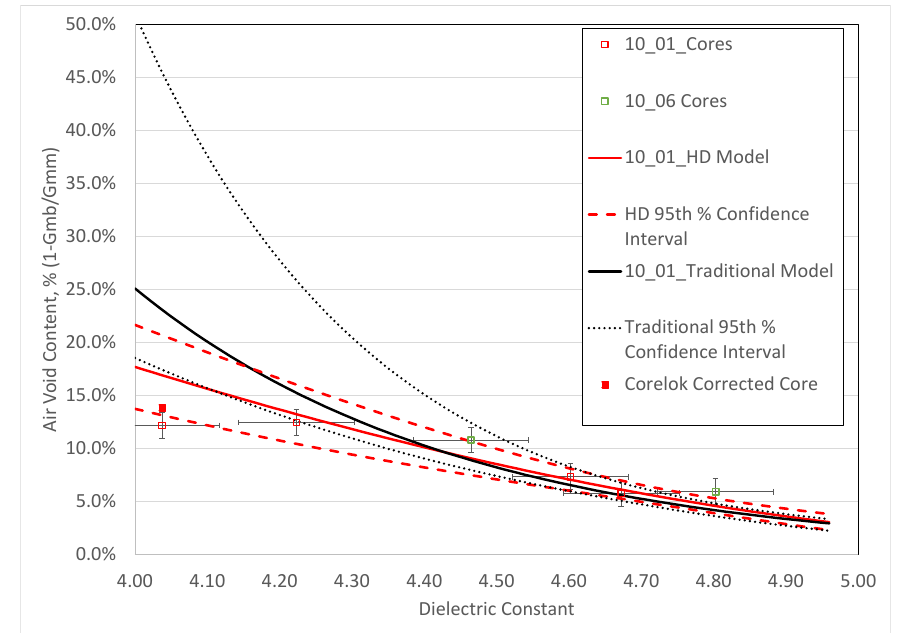
Figure 20. Prediction stability of Hoegh – Dai (HD) model in comparison to the conventional model when using asphalt specimen generated predictions with comparison to field measurements and core validation.